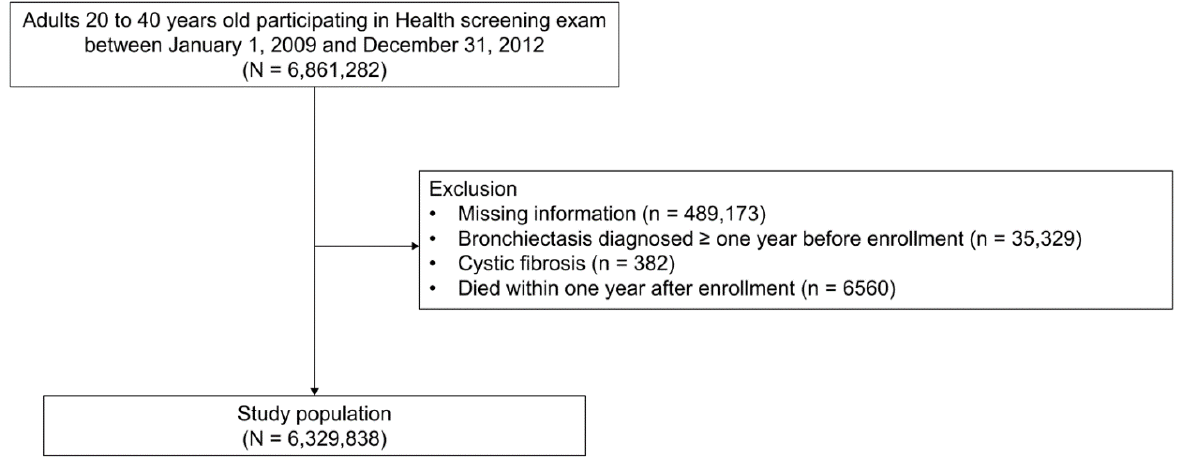
Figure 1. Flow chart of the study population.